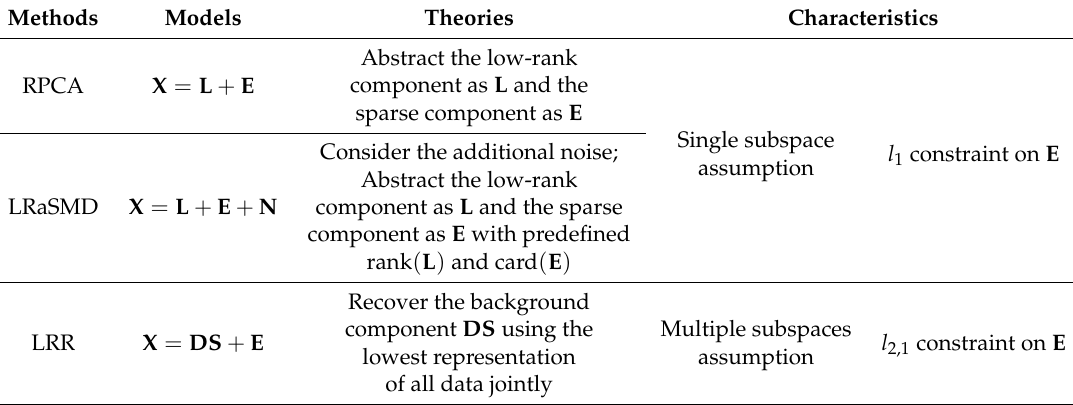
Figure 1. Difference between the l 1 constraint in RPCA and the l 21 constraint in LRR. Each square represents the digital number of a pixel in a band. The greens correspond to the backgrounds and the reds correspond to the anomalies. Table 1. Comparison of models and characteristics of RPCA, LRaSMD and